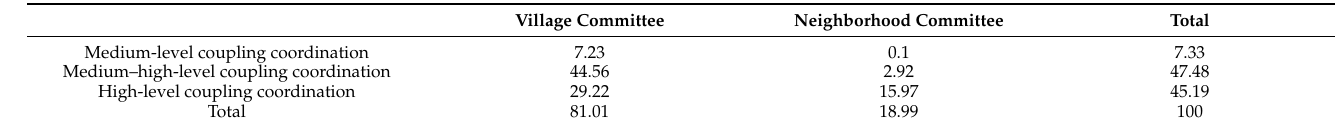
Table 2. Three-dimensionallocationcouplingandcoordinationdistributionofvillage(neighborhood)committees.